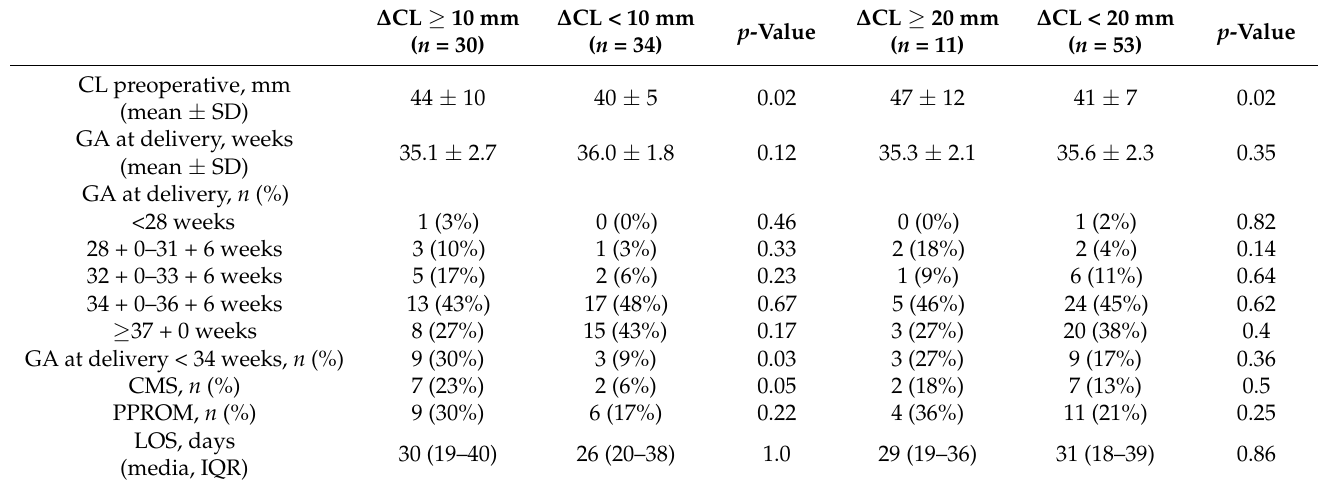
( n = 9) in comparison to the group of ∆ CL < 10 mm ( n = 3) (Table 5). In the group with ∆ CL ≥ 10 mm, the mean GA at delivery was still 35.1 weeks and the rate of extremely and very preterm born infants was not significantly different between the two groups (Table 5). In the group of ∆ CL > 10 mm a nearly 4-times higher rate of CMS was found ( p = 0.045) (Table 5). Using the higher cut-off of ∆ CL ≥ 20 mm, these differences could not be reproduced (Table 5). Table 5. Comparison of the groups with cervical length dynamics ( ∆ CL) ≥ 10 mm or <10 mm and ≥ 20 mm or <20 mm until discharge after fetal spina bifida